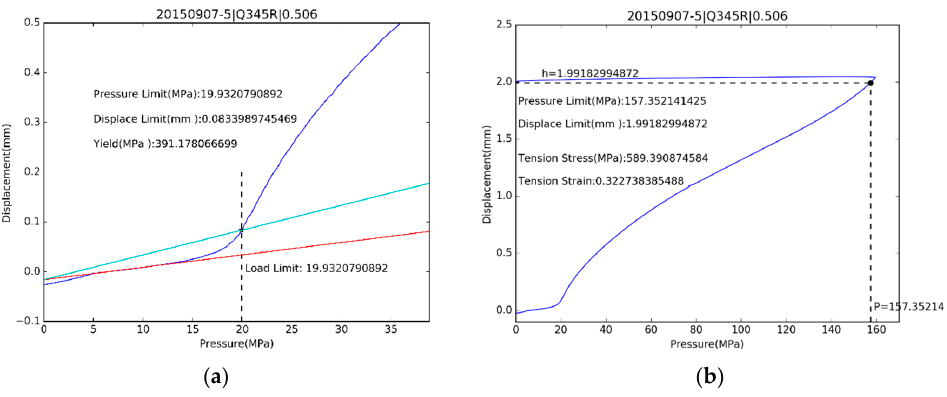
Figure 11. The estimation for ( a ) yield stress and ( b ) ultimate tensile strength of Q345R. Both the testing results from conventional tensile test and hydraulic bugle test are shown in Figure 12. By comparison of test results, the HBT method and the estimation equations are reliable. All parameters used in the estimation have physical meaning. Materials 2017 , 10 , 23